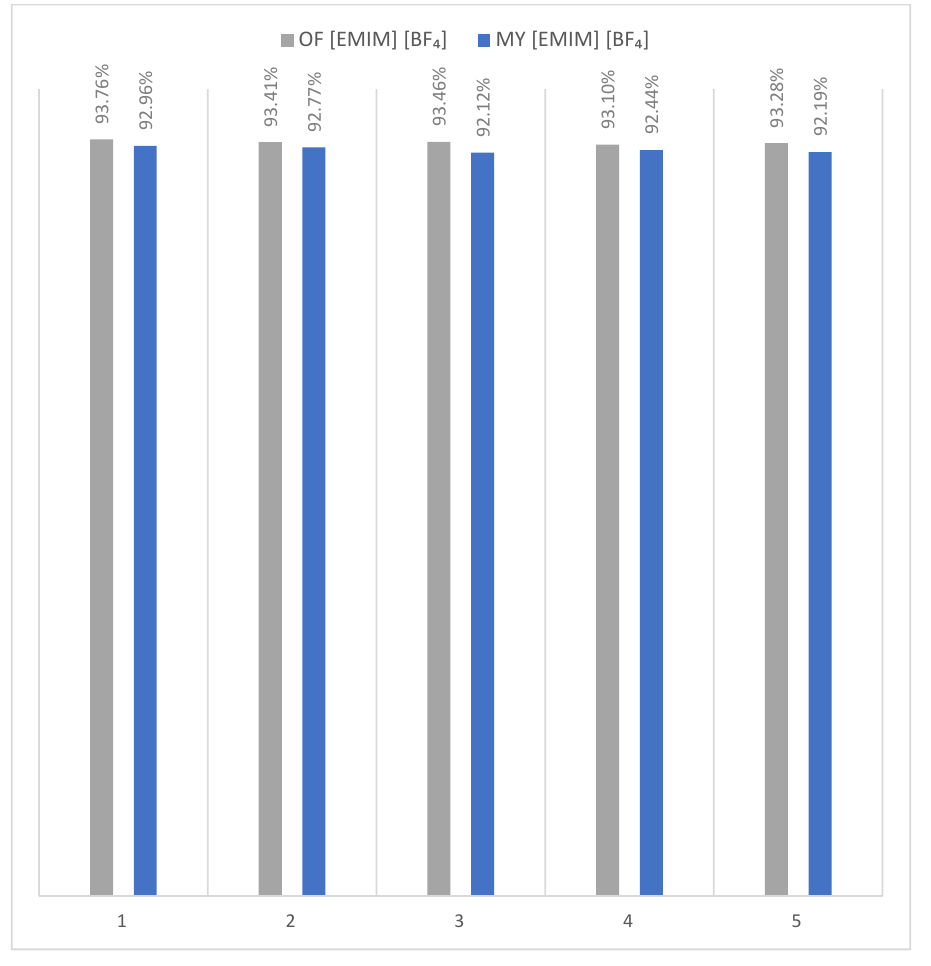
Figure 5. Comparison of the values of enantiomeric excesses of products in five reaction cycles with the reused lipases from Candida rugosa in enantioselective biotranformation of ( R , S )-atenolol.